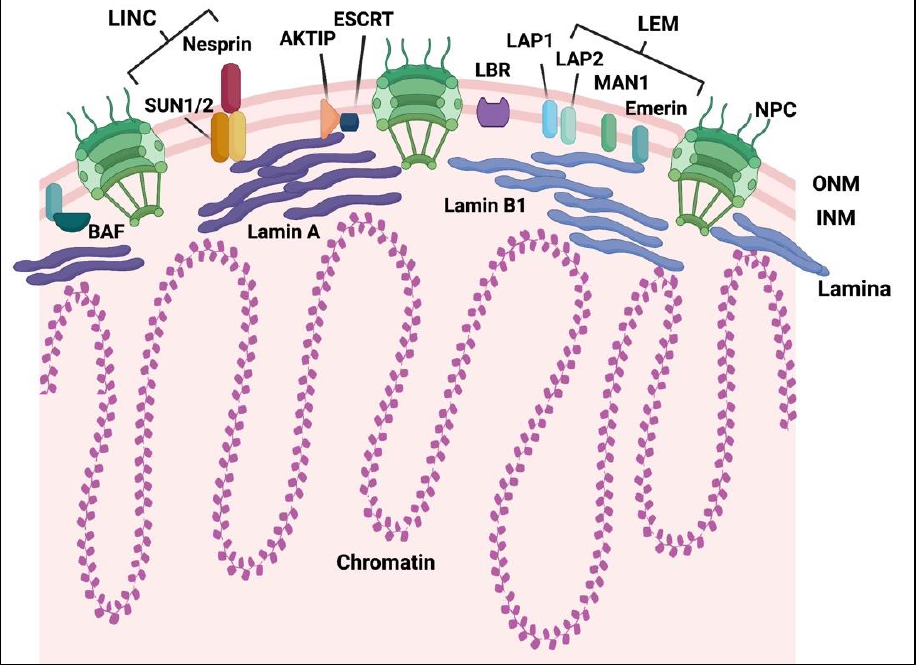
Figure 1. Nuclear envelope in mammals. Graphical representation of the mammalian nuclear envelope (NE) and its key components. The NE is composed of two layers, the inner and outer nuclear membrane (INM and ONM), the nuclear pore complex (NPC) and the nuclear lamina network connected with chromatin. Several key components of the NE are shown: the Linker of the Nucleoskeleton and Cytoskeleton (LINC) complex (SUN1/2, and nesprin proteins), the main lamins (lamin A and B), LAP1, the LEM family (LAP2, Emerin and MAN1), the lamin B receptor (LBR), as well as BAF, which interacts with both LEM and lamina, AKT Interacting Protein (AKTIP) in connection with lamins and the Endosomal Sorting Complex Required for Transport (ESCRT) complex.